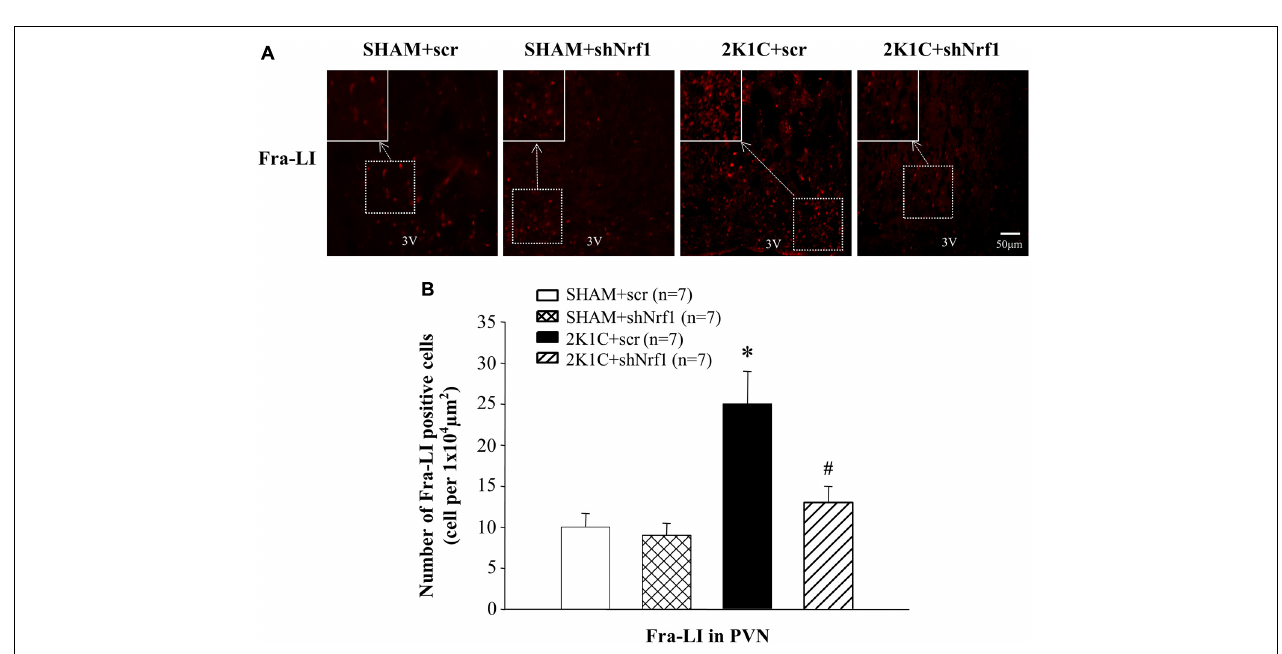
FIGURE 4 | Effects of knocking down of Nrf1 on Fra-LI expression in PVN of hypertensive rats. (A) Immunofluorescence for Fra-LI in PVN in different groups. (B) Changes of number of Fra-LI positive cells in PVN. ∗ P < 0.05 vs. control animals (SHAM + scr or SHAM + shNrf1). # P < 0.05 2K1C + shNrf1 vs. 2K1C + scr.